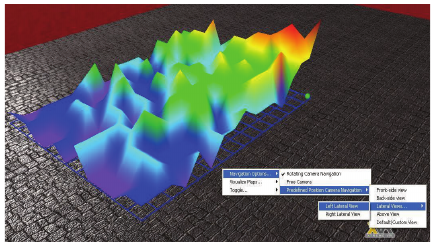
Figure 7: 3D radio map representation of the signal’s power distribution inside the indoor profile.